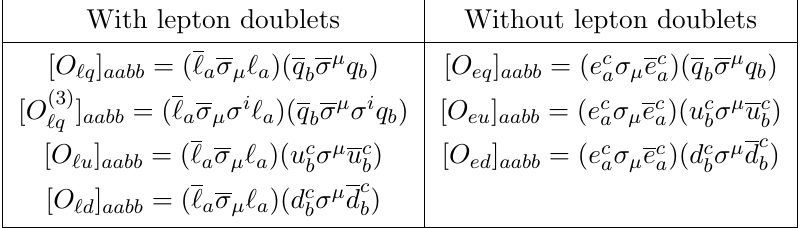
Table 2 . Flavor- and chirality-conserving 2-lepton-2-quark operators in the SMEFT